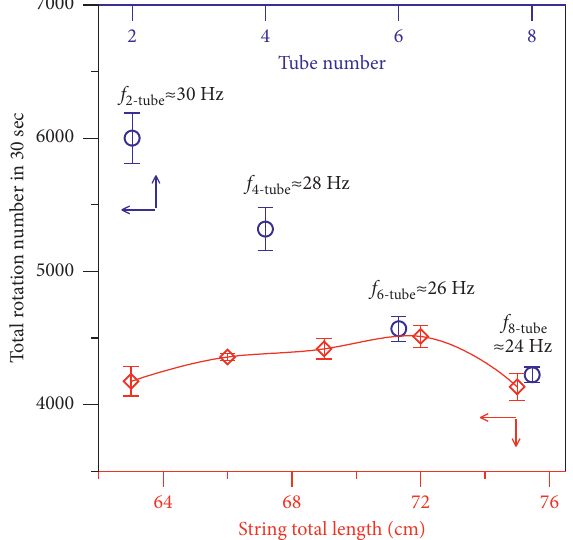
Figure 3: Effects of tube number ( ○ , n ˆ 6) and string length ( ◇ , n ˆ 3) to the total rotational number. Frequency ( f ), pulling on frequency.